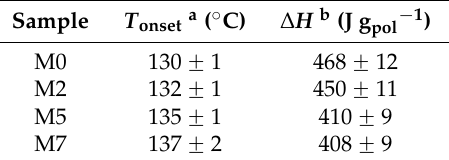
Table 3. Analysis of DSC measurements.